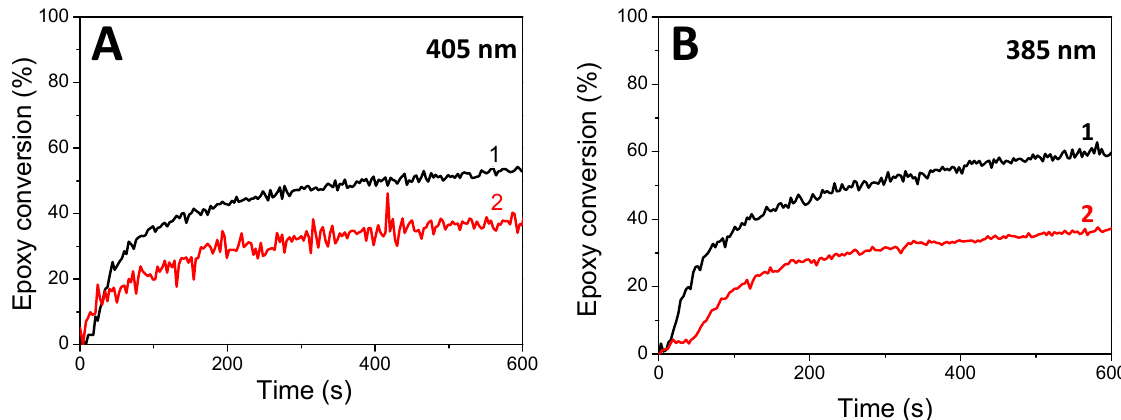
Figure 5. Kinetic profiles for the cationic photopolymerization of EPOX under LEDs@ ( A ) 405 nm and ( B ) 385 nm irradiation with (1) HNQA/ Iod (0.5/2% w / w ) and (2) HNQE /Iod (0.5/2% w / w ) under air.